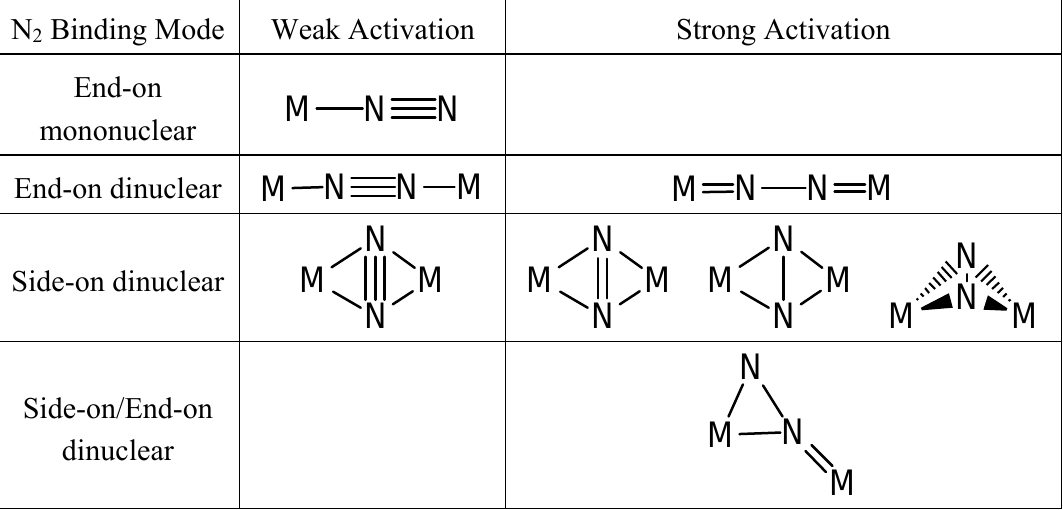
activation according to bonding mode, adapted from Fryzuk Table 1. N 2